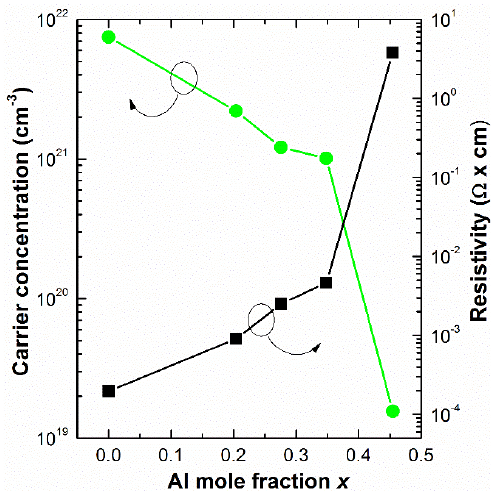
Figure 2. Dependence of the room temperature carrier concentration and resistivity of the Al x In 1 − x N on sapphire films vs the Al mole fraction x. For x > 0.45 electrical measurements were not reliable due to the high resistivity of the layers, being above the resolution of the Hall effect setup.